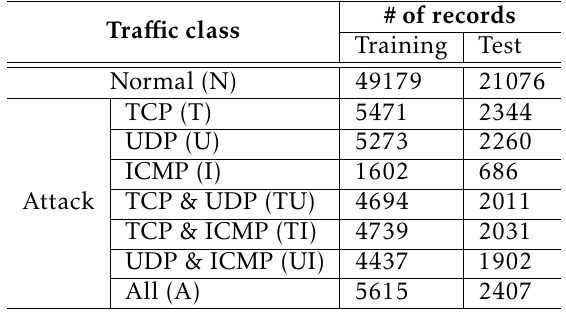
Table 6. Number of records in the training and test datasets